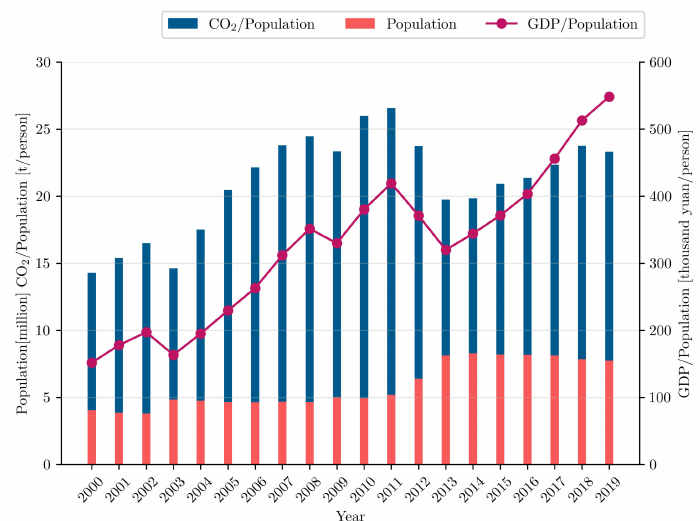
Figure 4. Added value and carbon intensity of China’s logistics industry in